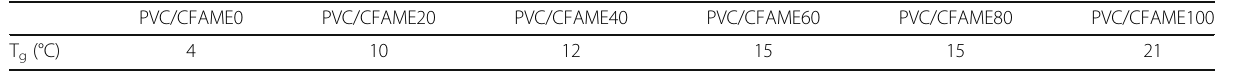
Table 3 Glass transition temperatures of PVC/CFAME x coatings as determined by DMA analysis